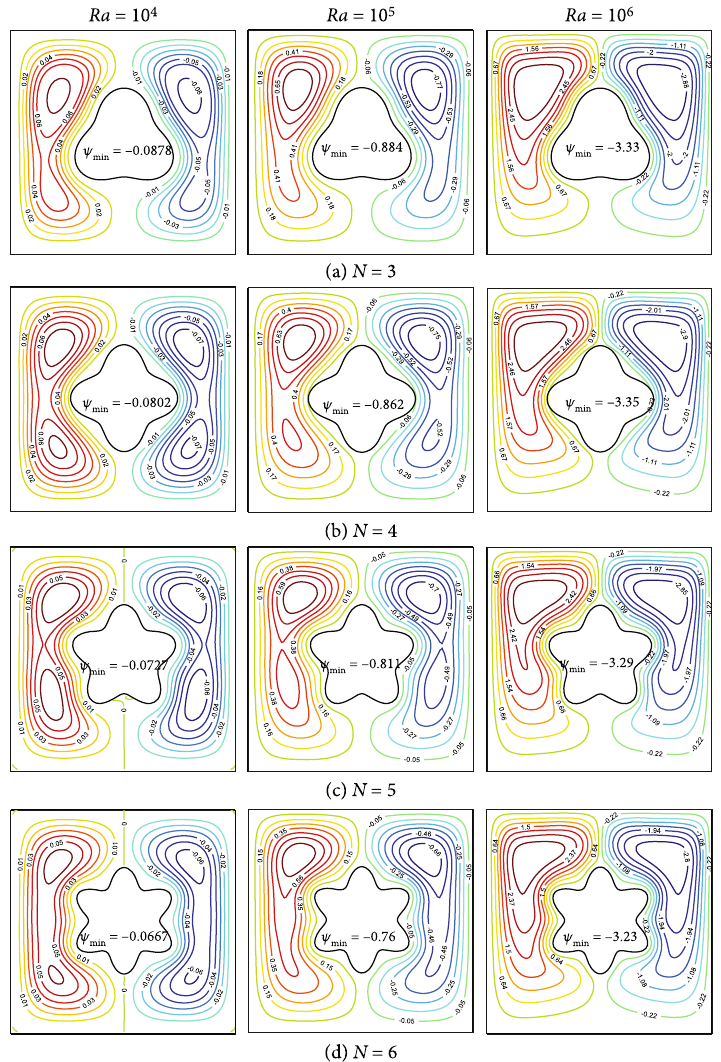
Figure 5: Streamlines for several Rayleigh numbers and varying the undulation number, N at A = 0 : 2 and ϕ = 0 : 03